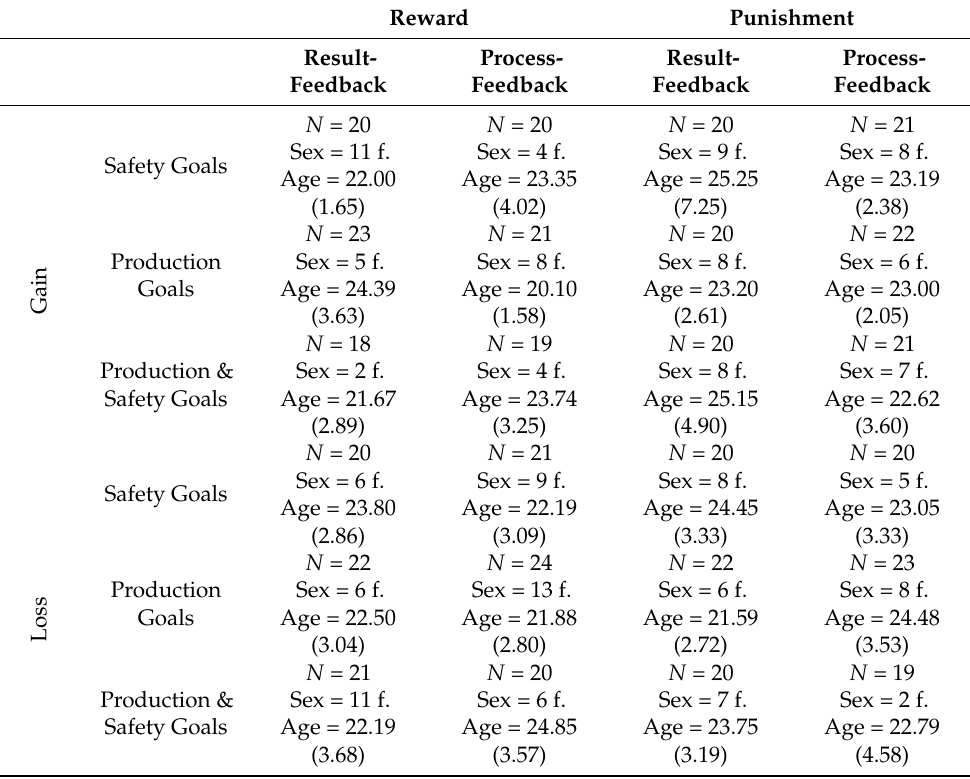
Table 3. Demographic details of each condition. Age = M ( SD